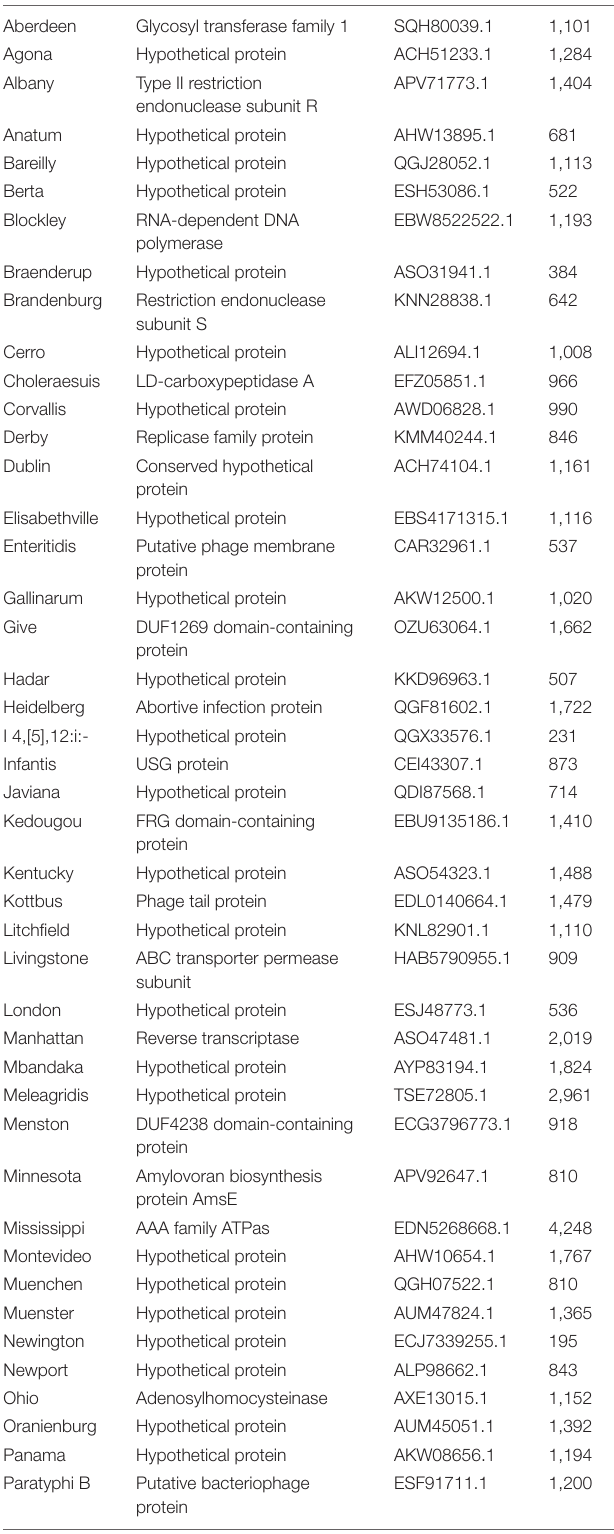
TABLE 2 | Information of gene markers obtained pangenome analysis.